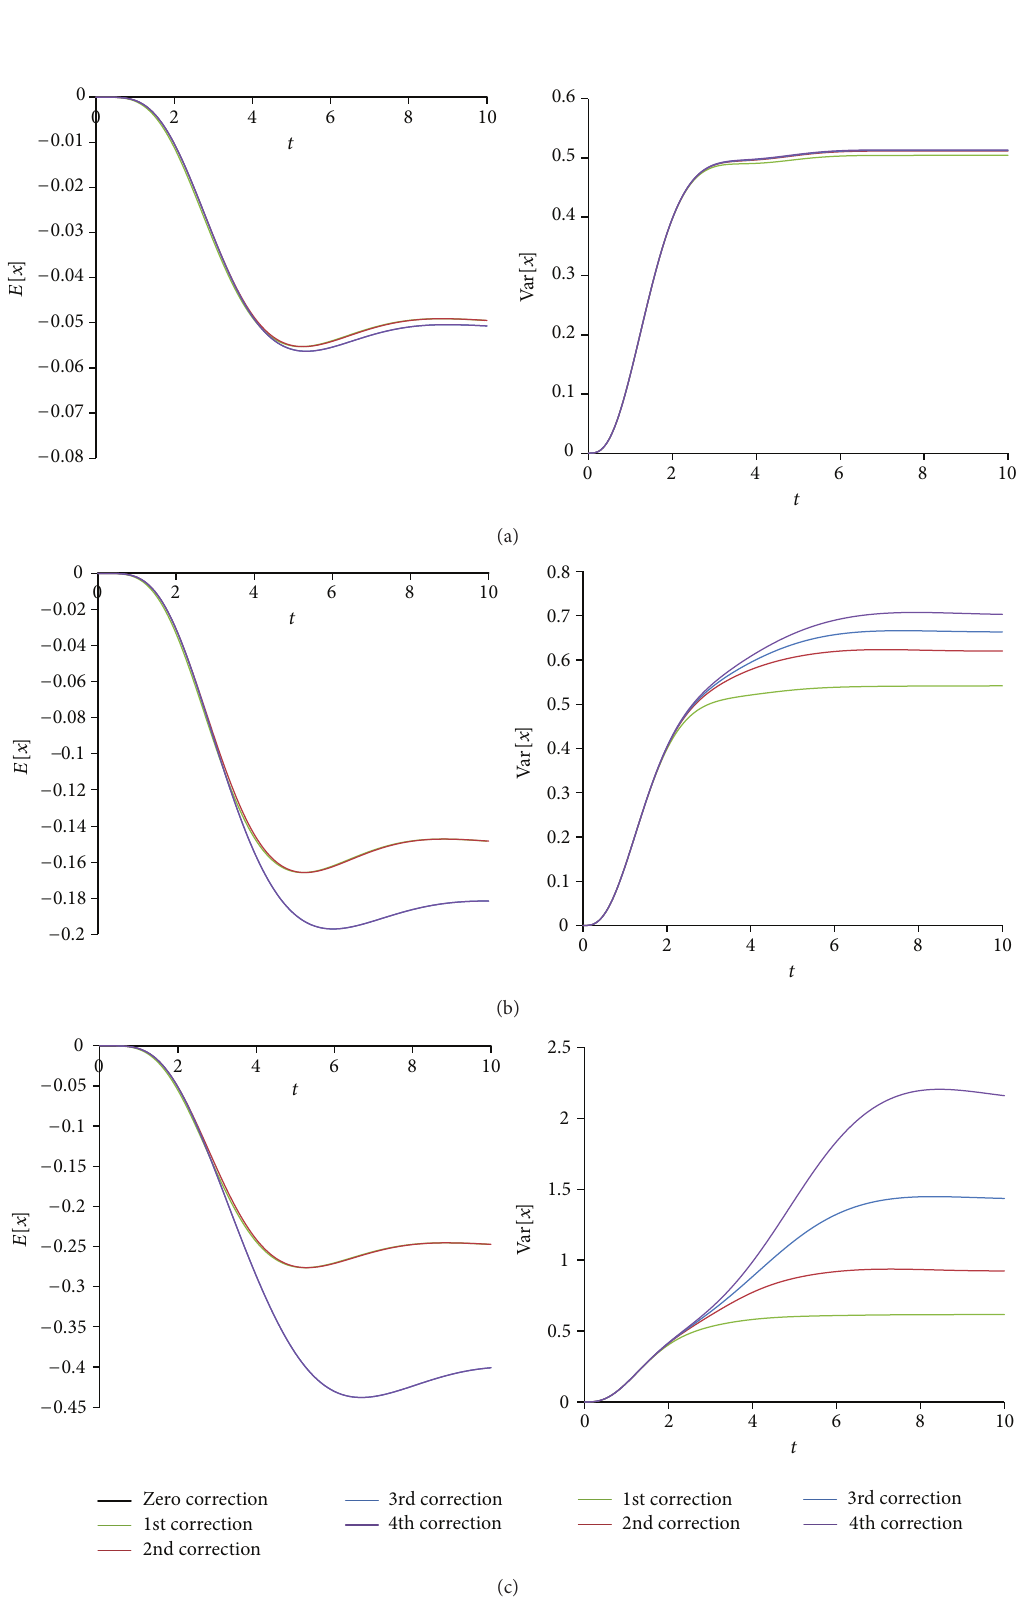
Figure 7: The second-order response mean and variance for (a) 𝜀 = 0.1 , (b) 𝜀 = 0.3 , and (c) 𝜀 = 0.5